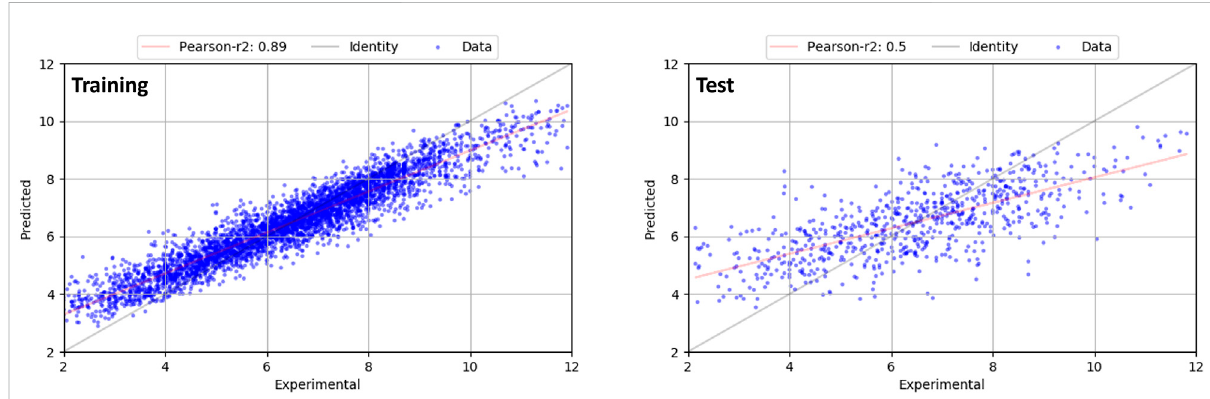
FIGURE 4 Graph of experimental pK i values on the x -axis versus predictions from the fi nal random forest model ( y -axis) for the training (left) and test dataset (right). Line of identity is shown in